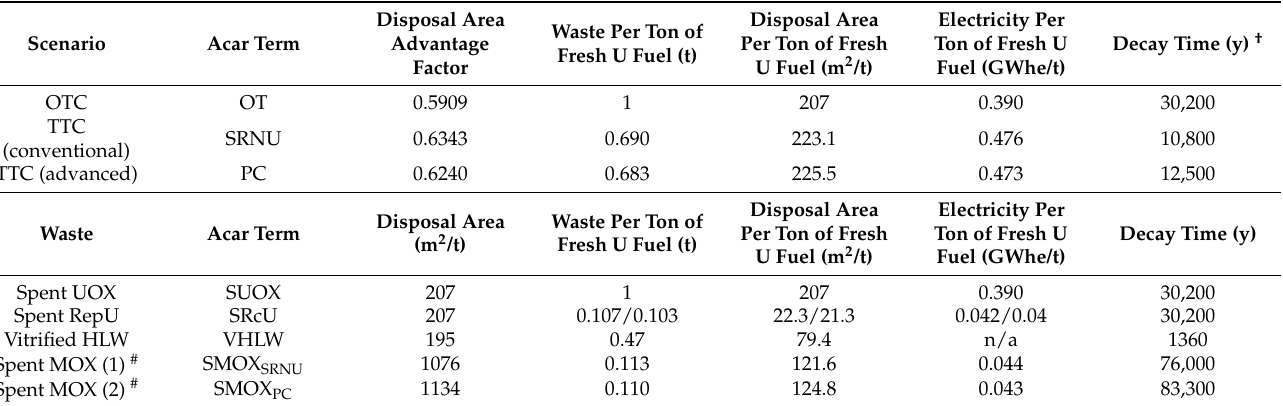
Table 10. Key results from Acar et al. [70] for 50 GWd/t burnup fuels (top for OTC and TTC scenarios and below for characteristics of the wastes and